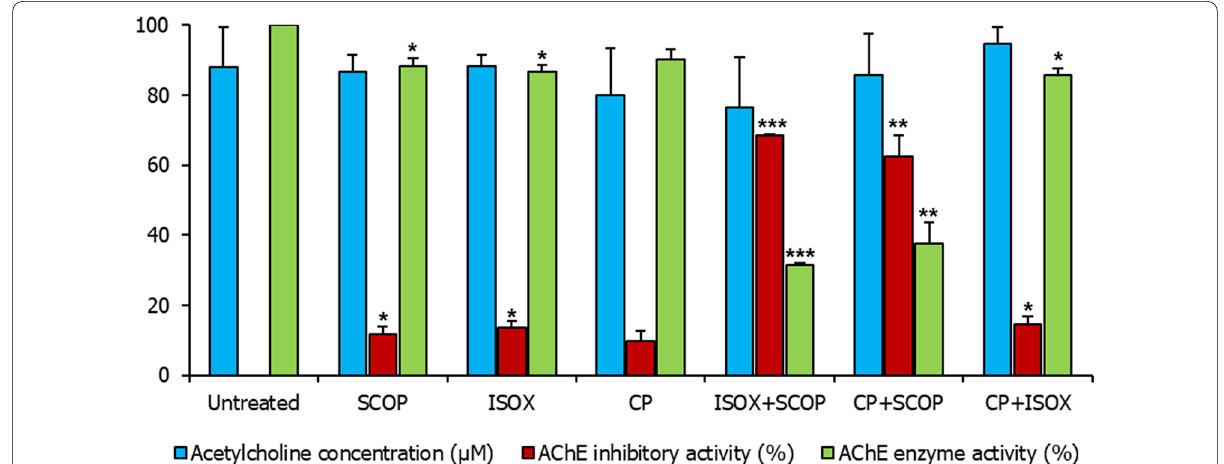
Fig. 2 Effect of test compound(s) on acetylcholinesterase activity and acetylcholine levels. Acetylcholine (ACh) levels (blue bars), acetylcholinesterase (AChE) inhibitory activity (red bars), and acetylcholinesterase enzyme activity (green bars) in 168 hpf larvae unexposed to any test compound (i.e. ‘untreated’), treated with scopolamine (SCOP), isoxazole (ISOX), Convolvulus pluricaulis (CP) and their combinations (ISOX CP SCOP, and CP ISOX) have been shown. Both the ACh level (µM) and AChE activity (%) have been expressed as mean + + Three independent experiments were conducted to determine ACh level and AChE activity, and in each of these experiments, three sets of 15–25 embryos were treated with the least toxic concentrations of SCOP (6.68 μM), ISOX (1.04 mM), and CP (0.38 mg/ml) and their combinations. The larvae were treated with the AChE inhibitor (i.e. ISOX or CP) one hour before treatment with SCOP. *, **, and *** indicate p-value < 0.5, < 0.01 and < 0.001 of two-tailed unpaired t-test for untreated versus test groups